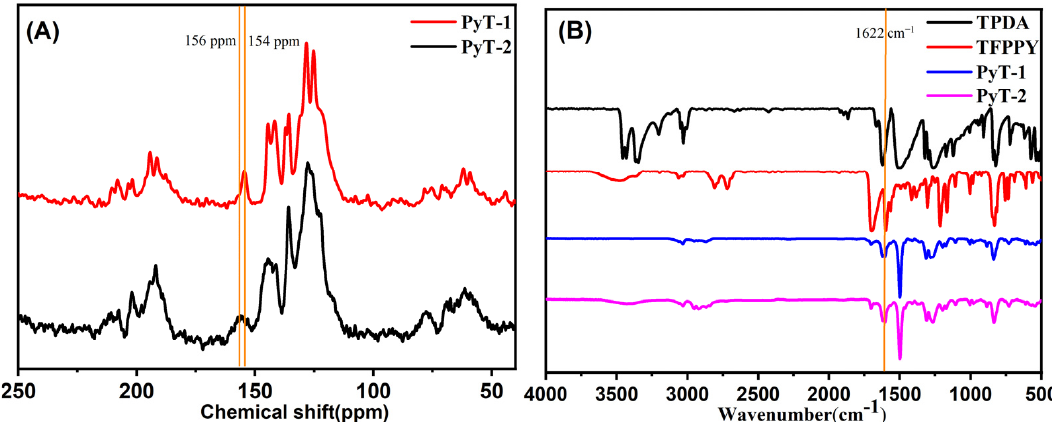
Figure 1. 13 C solid-state NMR spectra of ( A ) PyT-1 and PyT-2; FTIR spectra of ( B ) TPDA, TFPPY, PyT-1, and PyT-2.